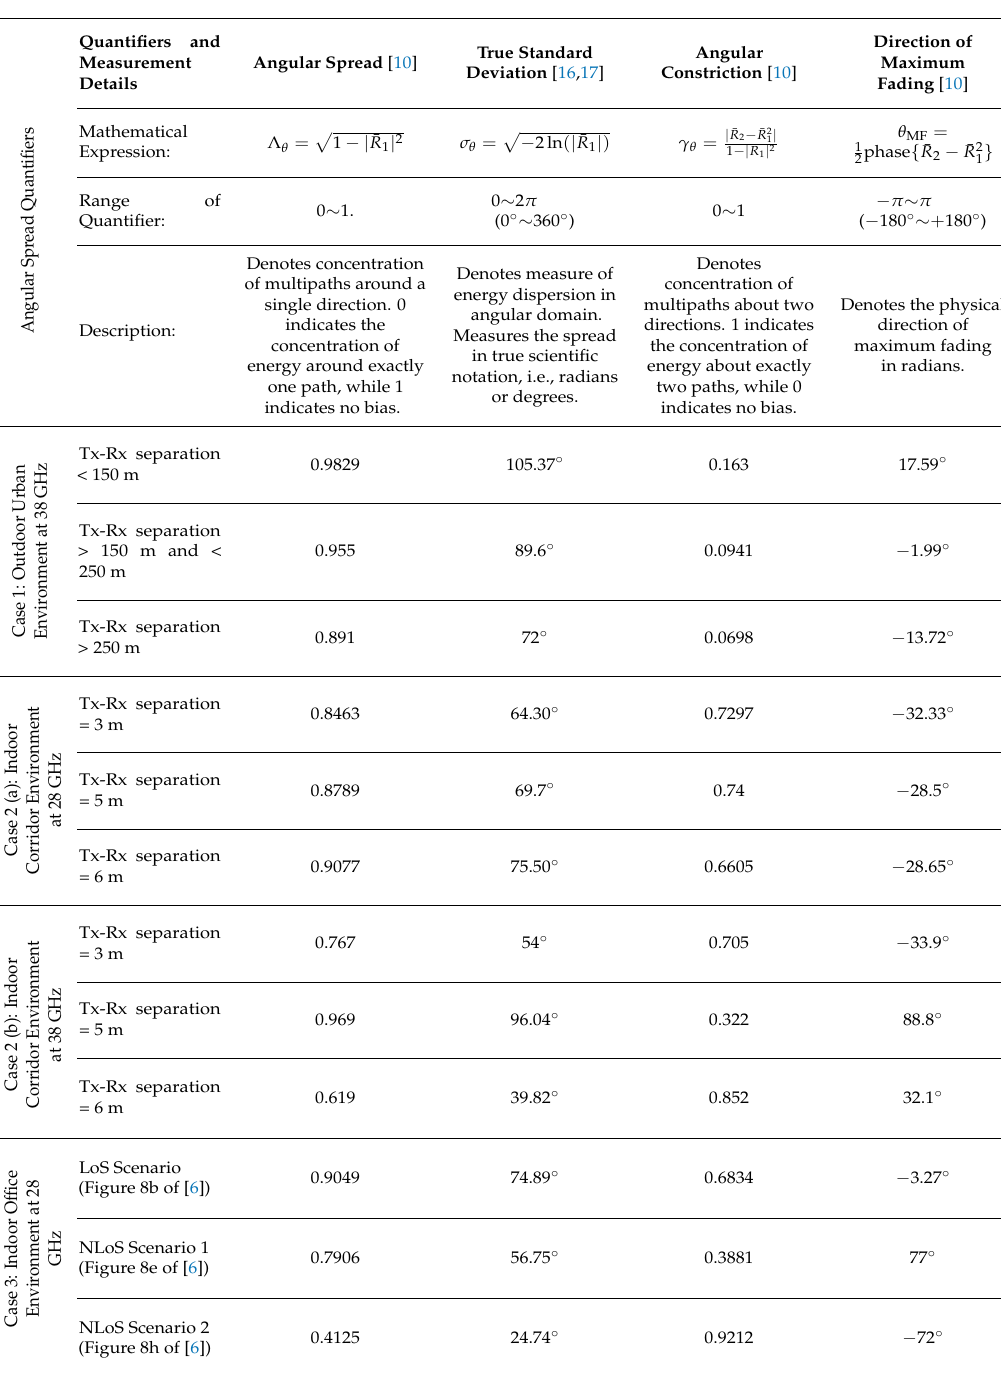
Table 2. Quantification of Angular Spread for mmWave outdoor and indoor radio propagation